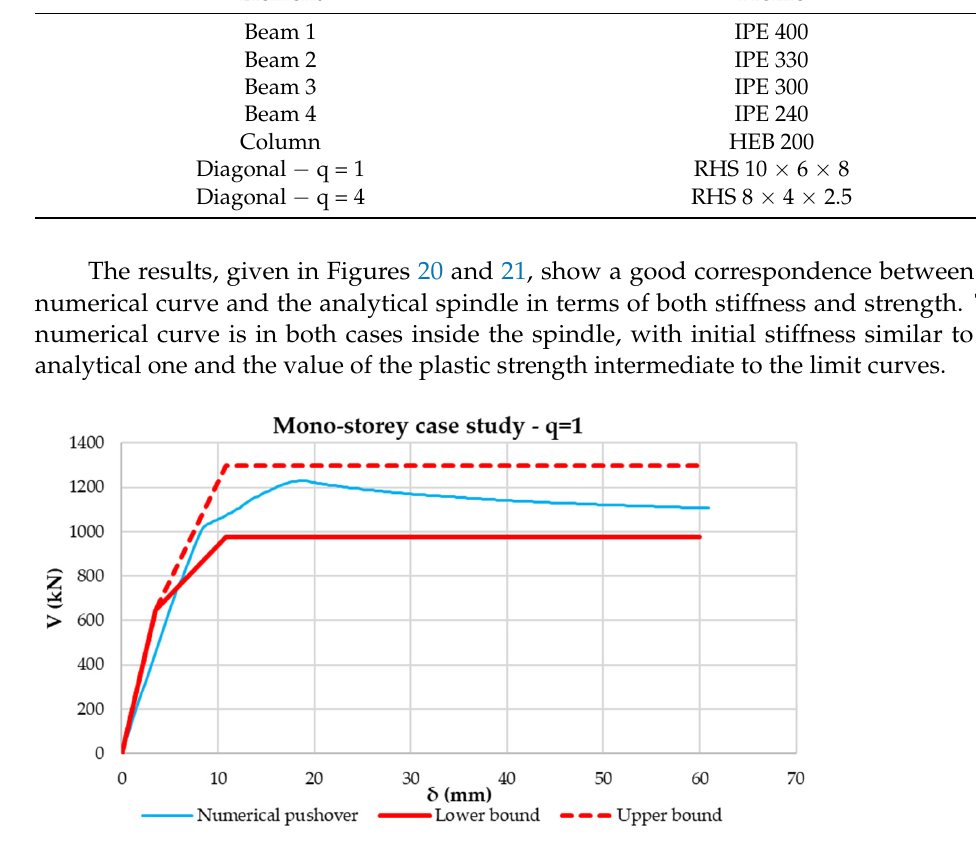
Table 5. Loads applied to the one-floor case studies. Figure 19. Warping of the floors and numbering of the beams (valid for all case studies; measure- ments in m). Table 6. Beam and column cross-sections of the one-floor case studies after vertical static analysis design.